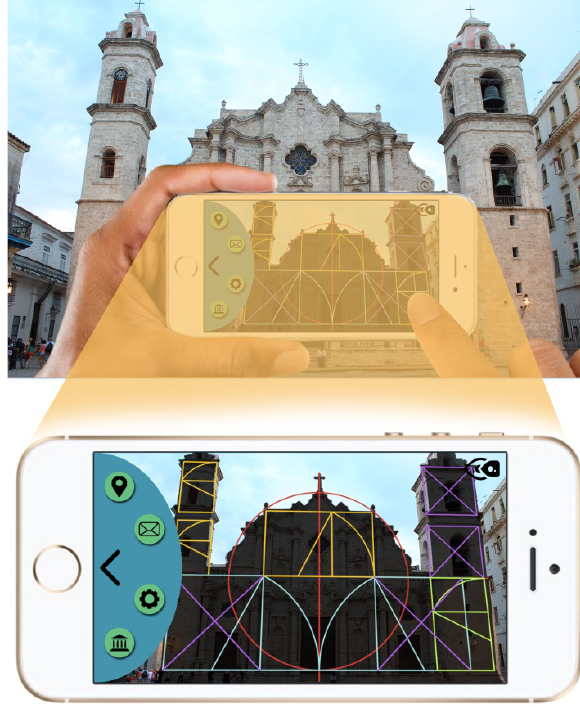
Figure 16. Example of an application of aumented reality (Catedral de la Virgen Maria de la Conceptión Inmaculada - Plaza de la